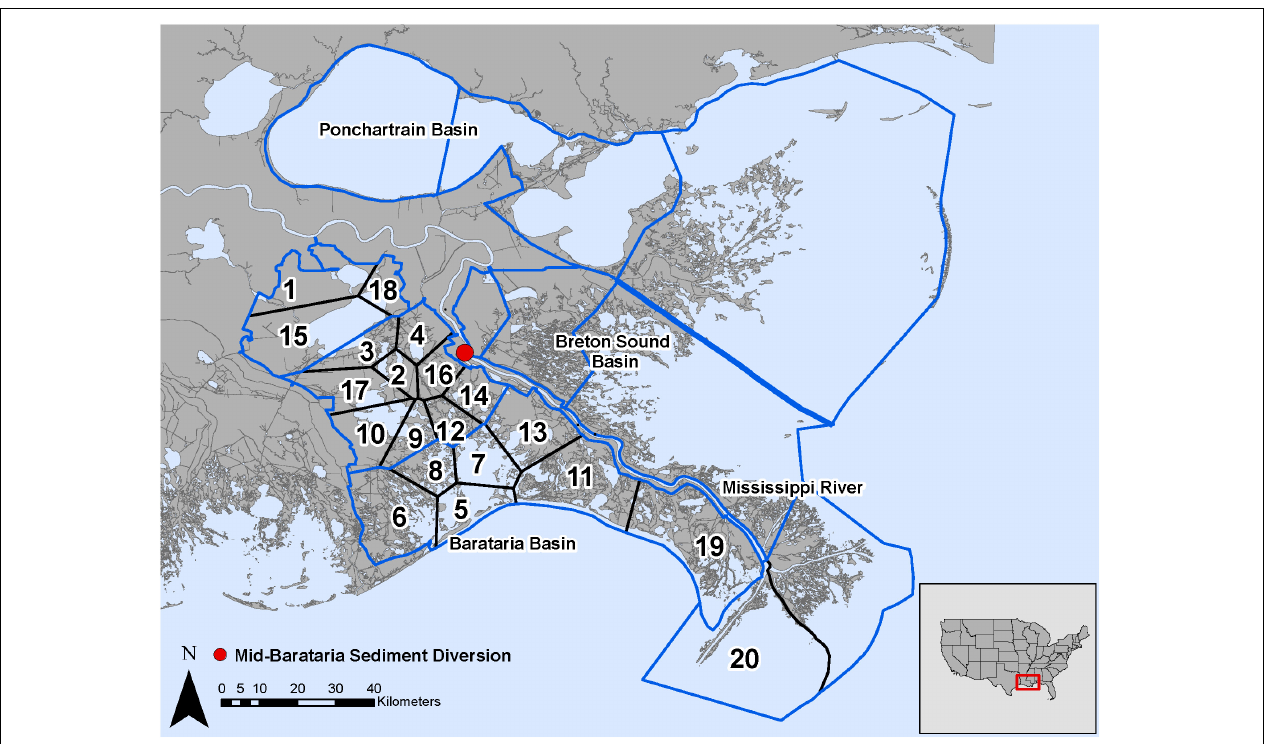
FIGURE 5 | Model domain in the Mississippi River Delta, United States for the EwE (outlined in blue) and CASM (numbered polygons) calibrated simulations and location of the Mid-Barataria Sediment Diversion (red point).